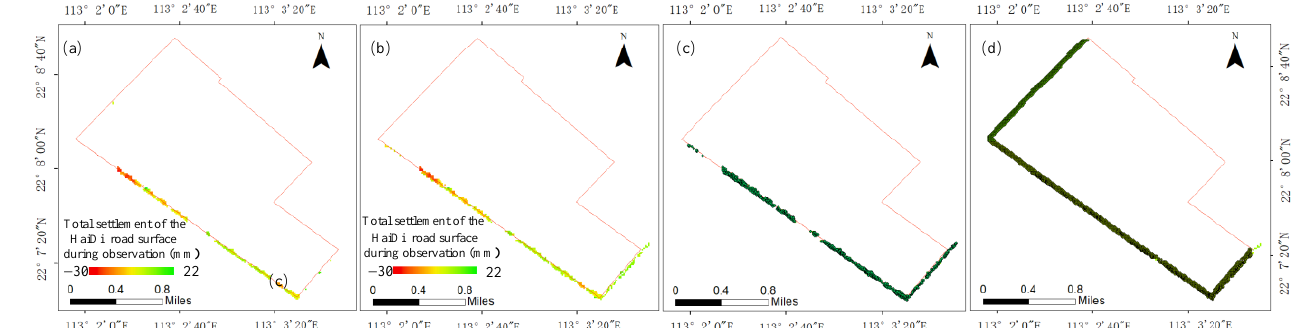
Figure 18. ( a ) the road settlement monitored by SBAS-InSAR ( b ) The road settlement obtained af- ter the fusion of PS-InSAR ( c ) the grid center points extracted by fusion InSAR ( d ) the buffer estab- lished according to the road width and the grid center points extracted.